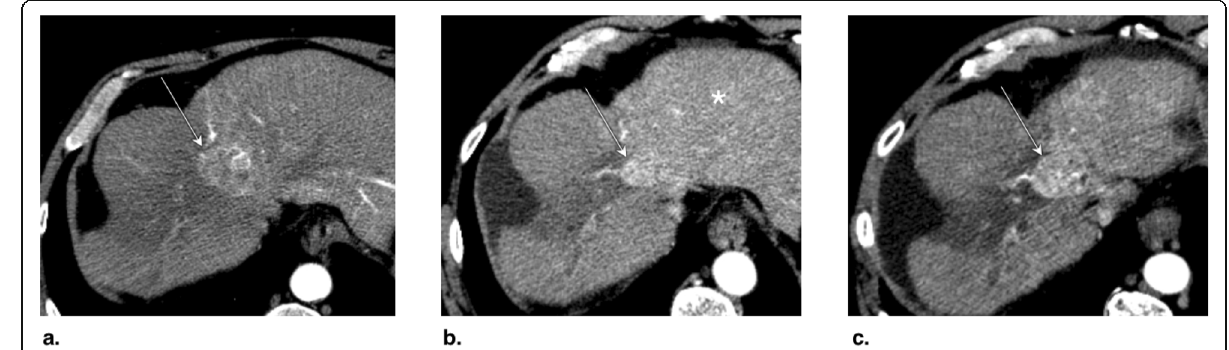
Fig. 34 Axial CT in late arterial phase obtained ( a ) pretreatment: image shows a 4-cm LR-5 observation (arrow) in segment IVa. b 3 months post left lobar transarterial radioembolization (TARE): image shows tumor regression and perfusional changes in left liver (asterisk) related to TARE. c 6 months post TARE: image shows tumor progression (arrow) compatible with recurrence. The treated observation is categorized LR-TR